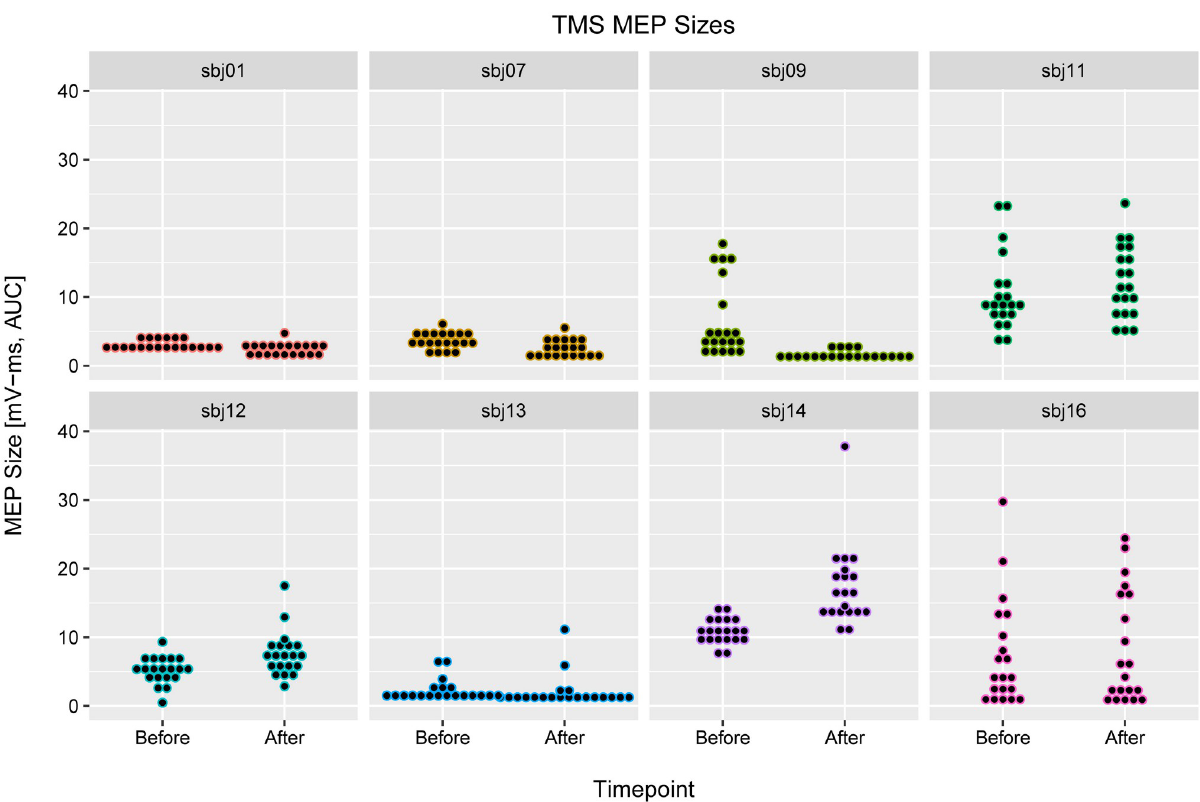
Fig 5. TMS MEP sizes, before and after tUS. Each subplot contains data from one subject: trials before and after tUS on the left and right, respectively. Each point marks the size of one MEP (area under the curve, mV-ms). Points are organized into vertical-axis bins to allow visualization akin to a violin plot (i.e. original data are not discrete values). Using amplitude instead of area under the curve did not change the results (S15